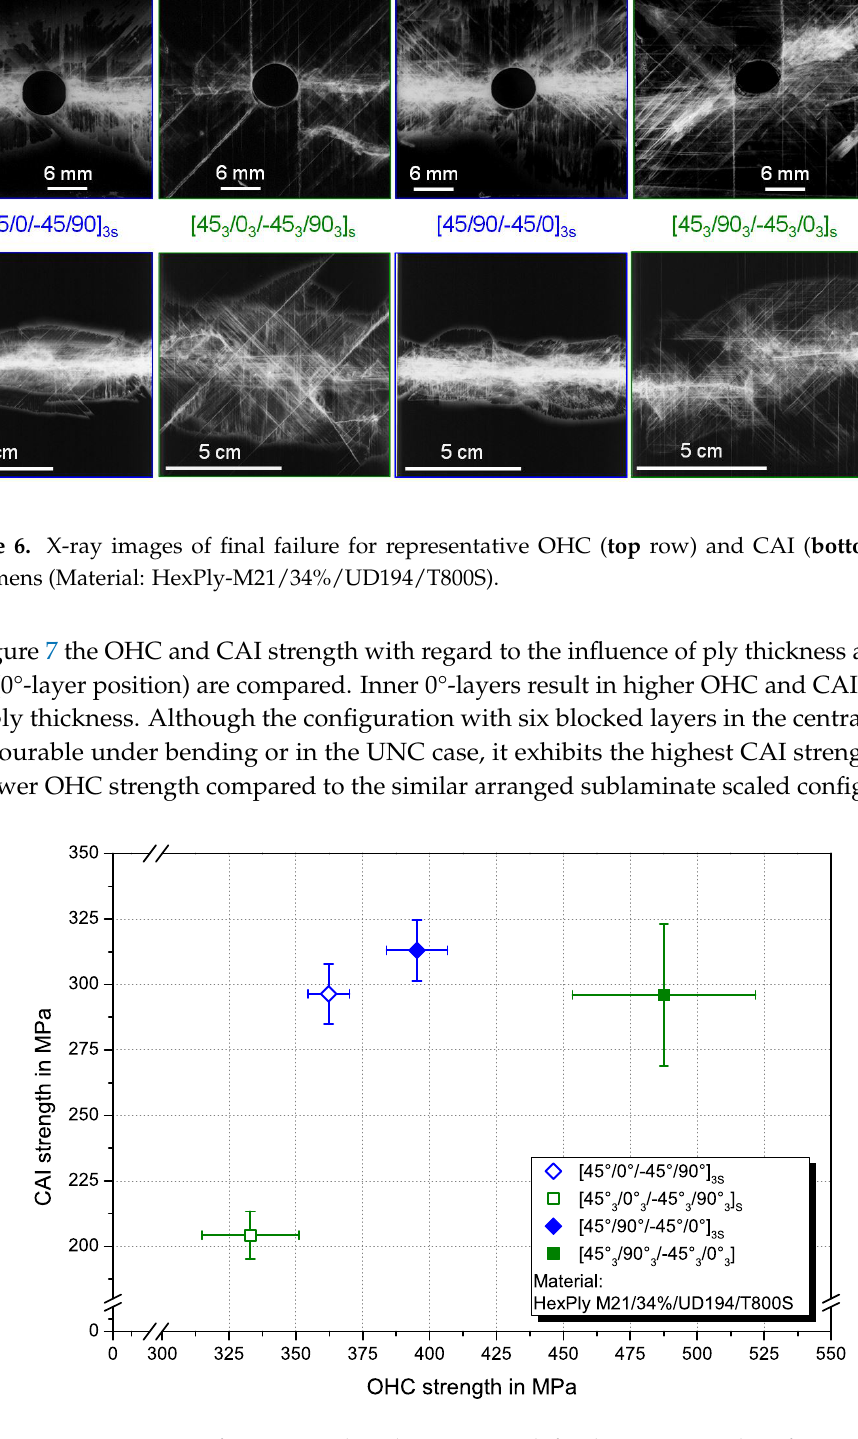
Figure 7. Comparison of CAI strength and OHC strength for the investigated